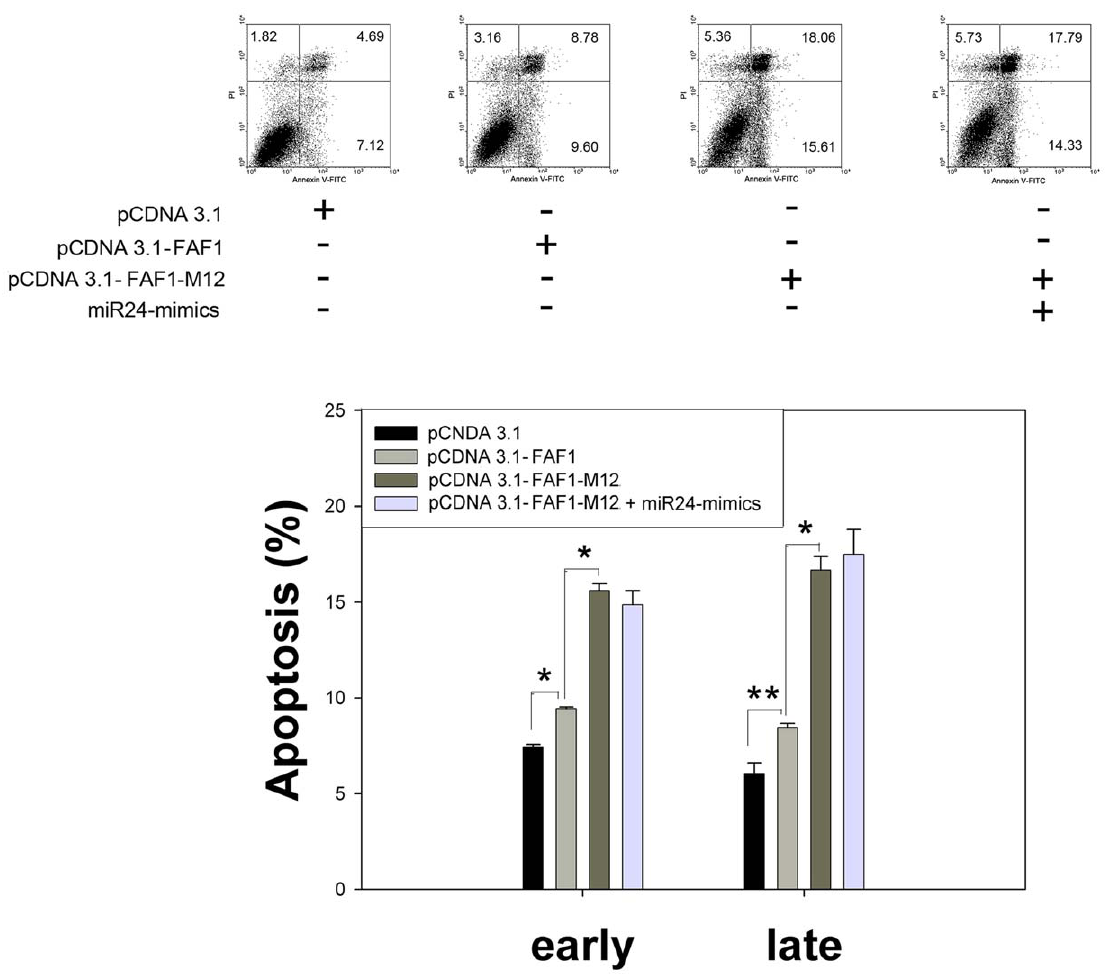
Figure 4. miR-24 regulates apoptosis by binding to the ORF region of the FAF1 gene. DU-145 cells were treated as indicated and apoptosis was measured by FACS 36 h after transfection (n=3 6 SE, * p , 0.01, ** p , 0.05). Synonymous mutations at the predicted miR-24 binding sites within FAF1 induced greater levels of apoptosis. Over-expression of miR-24 did not protect DU-145 cells from apoptosis induced by mutant FAF1. Vectors were transfected at a concentration of 100 ng per well; mimics and ASO were transfected at a concentration of 20 nM per well in a 12- well plate.